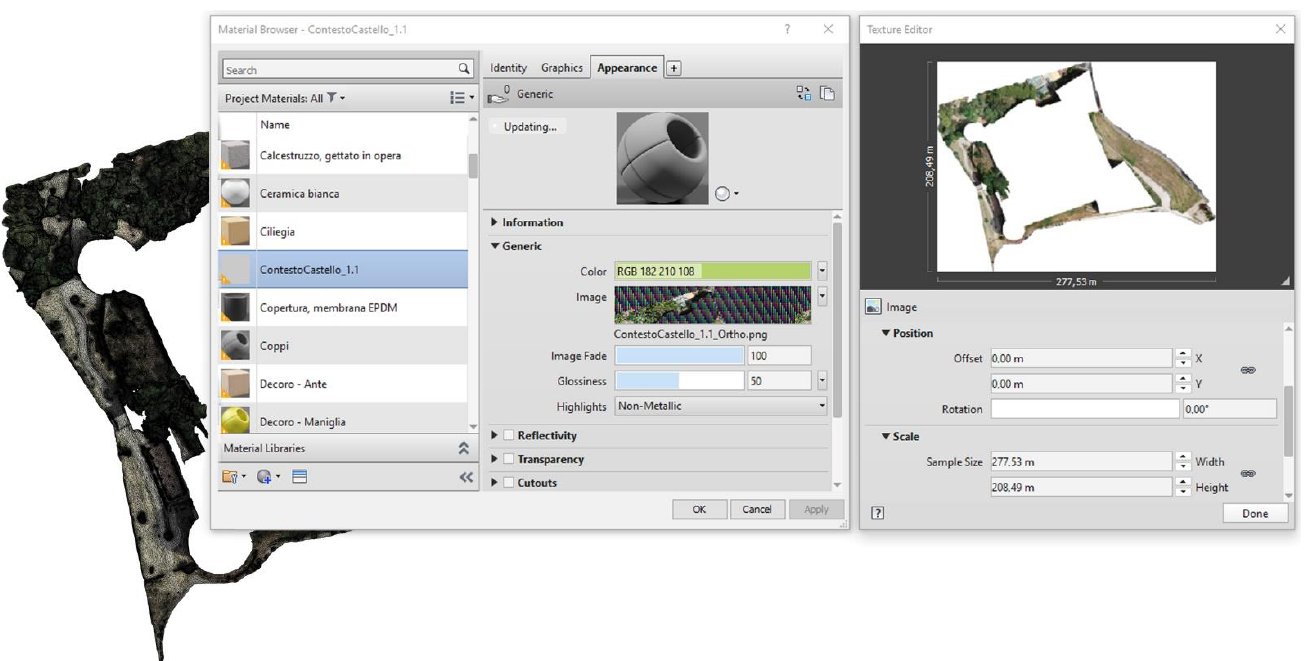
Figure 9. Real-sized orthoimages used as textures for the Revit materials (view of the Revit Figure 9. Real- sized orthoimages used as textures for the Revit materials (view of the Revit “Material Browser”). “Material Browser”).